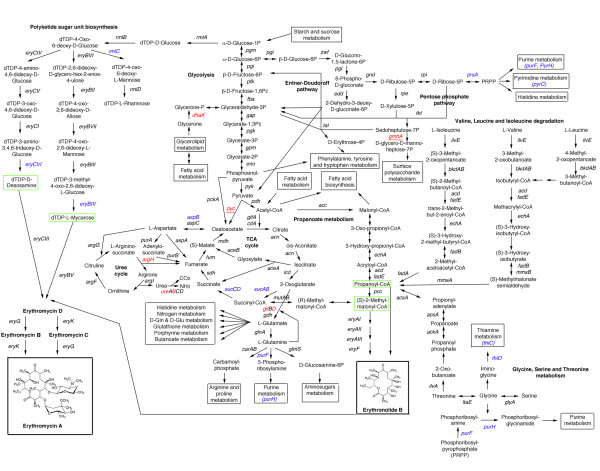
Overview of carbon and nitrogen metabolic pathways and their relationships with the biosynthesis of erythromycin. Genes affected by missense mutations are indicated in blue; genes affected by missense/nonsense mutations are shown in red. Single-copy genes are underlined.